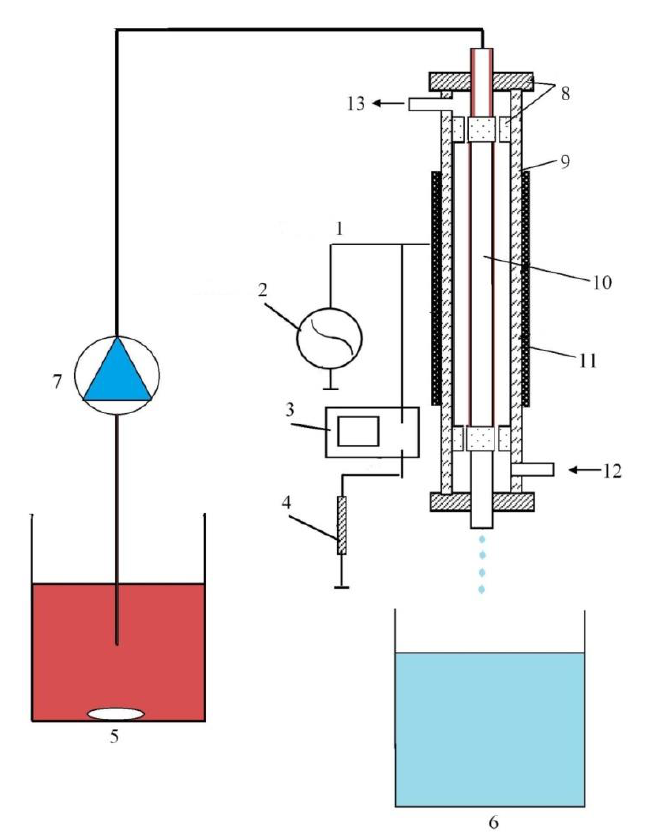
Figure 13. Scheme of the DBD reactor. 1—reactor, 2—power supply, 3—digital oscilloscope GW Instek GDS-2072, 4—resistor 100 Ohm, 5—solution reservoir + magnetic stirrer, 6—collector, 7—constant-flux pump, 8—Teflon insert, 9—dielectric, 10—internal electrode, 11—external electrode, 12—gas in and 13—gas out.